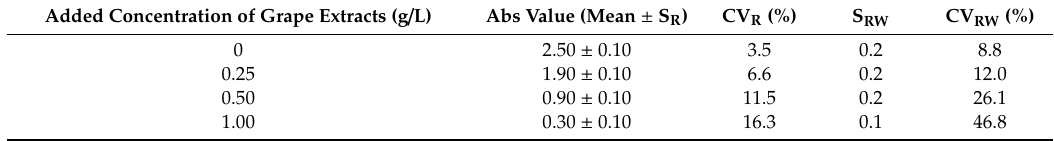
Table 3. Summary of the precision results of the seed extract at maturity stage. Added Concentration of Grape Extracts (g / L)